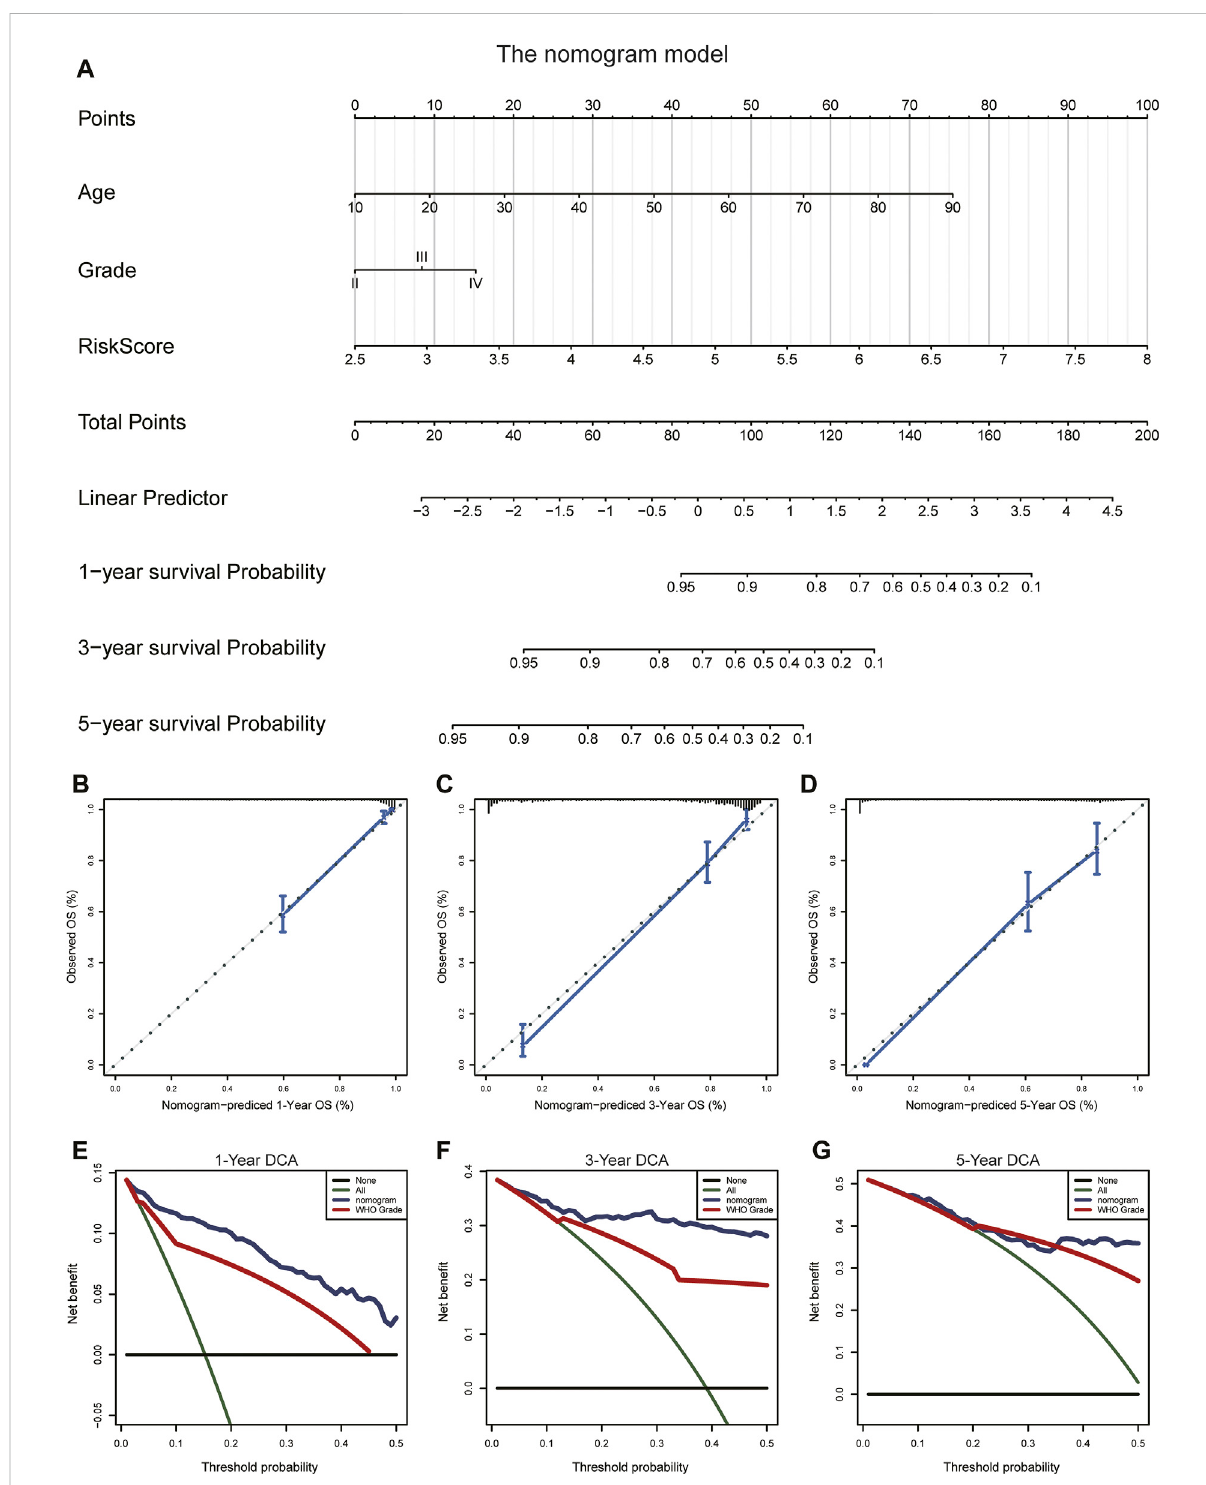
FIGURE 11 Construction and validation of the nomogram to predict OS in glioma patients. (A) The nomogram was established using age, WHO grade, and the ARG risk signature in the TCGA cohort. (B – D) Calibration curve of the nomogram for predicting the probability of OS at 1, 3, and 5 years in the TCGA cohort. (E – G) DCA of the OS-related nomogram at 1, 3, and 5 years in the TCGA